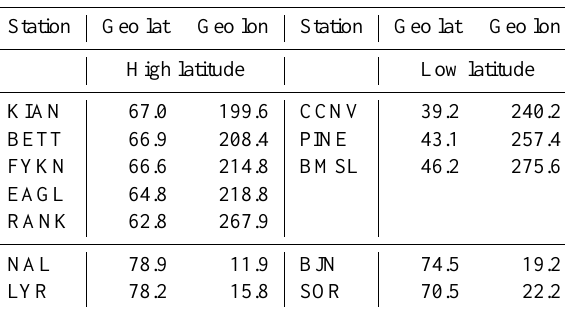
Table 4. Ground based magnetometers geographic location for the THEMIS magnetometers and from the Scandinavian IMAGE